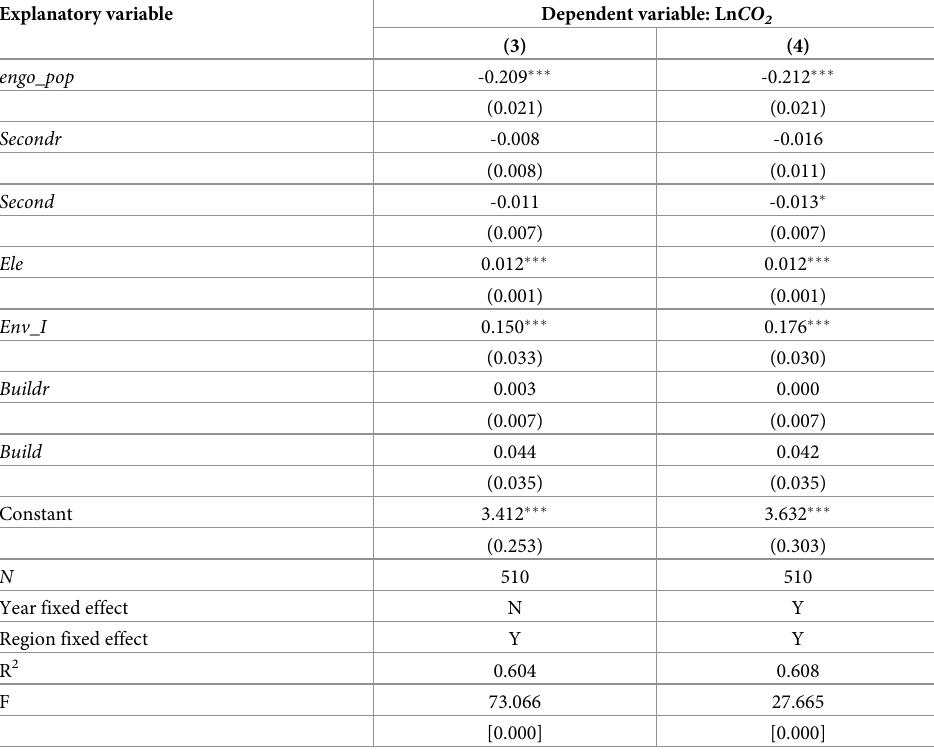
Table 3. Carbon emission reduction effect of